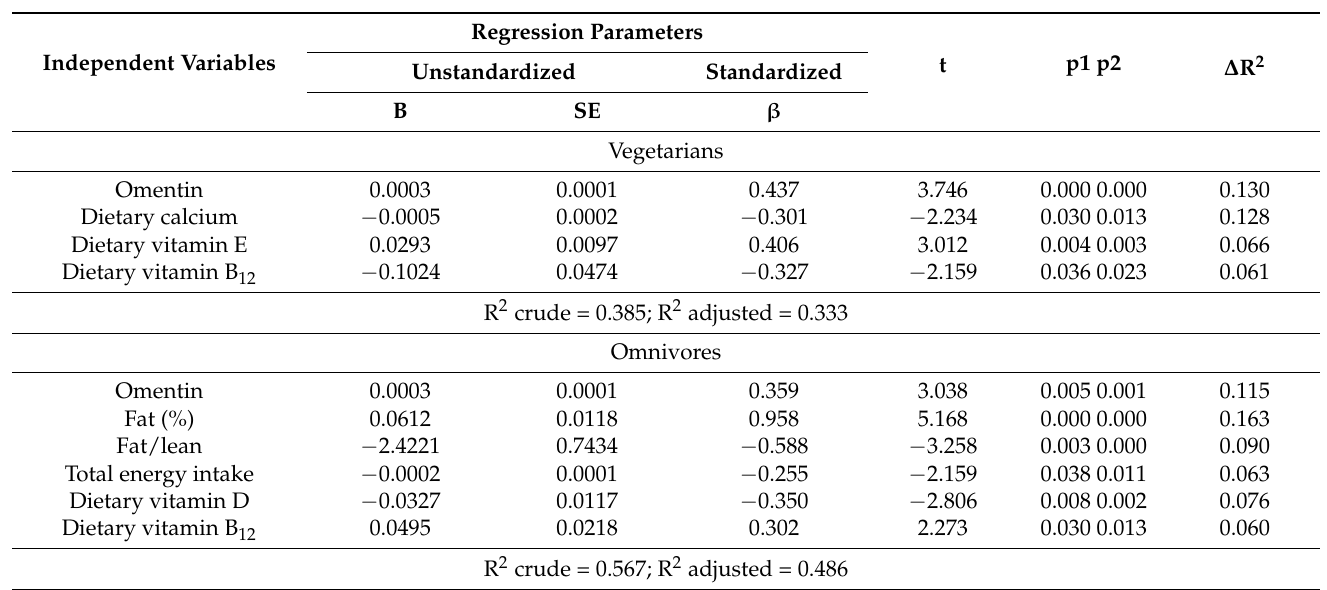
Table 5. Multivariate regressions of myostatin with independent variables in the groups of vegetarians and omnivores.